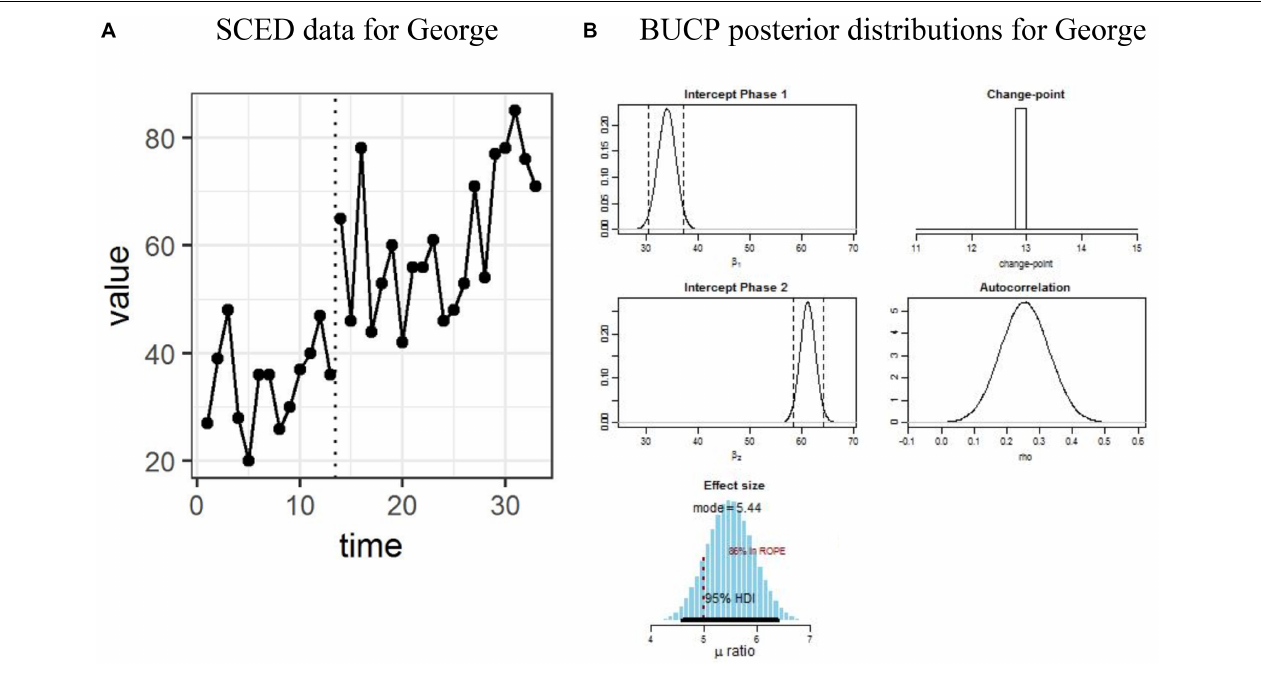
FIGURE 1 | (A,B) Single case experimental design (SCED) raw data for George in Dataset 1 and posterior distributions obtained with Bayesian unknown change-point (BUCP).